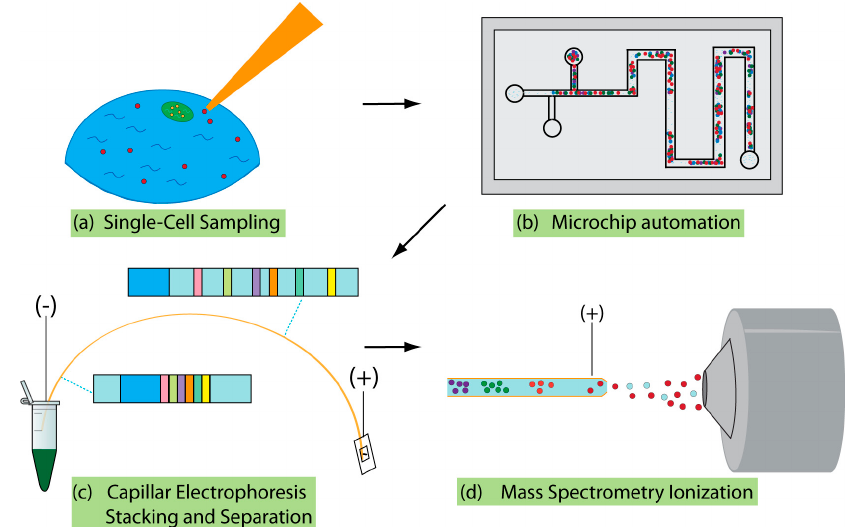
Figure 1. Diagram showing typical components of single-cell CE-MS analysis workflow, including ( a ) sampling, ( b ) microchip sample manipulation, ( c ) CE separation, and ( d ) ionization for MS acquisition. Not all single-cell workflows include all of these steps.